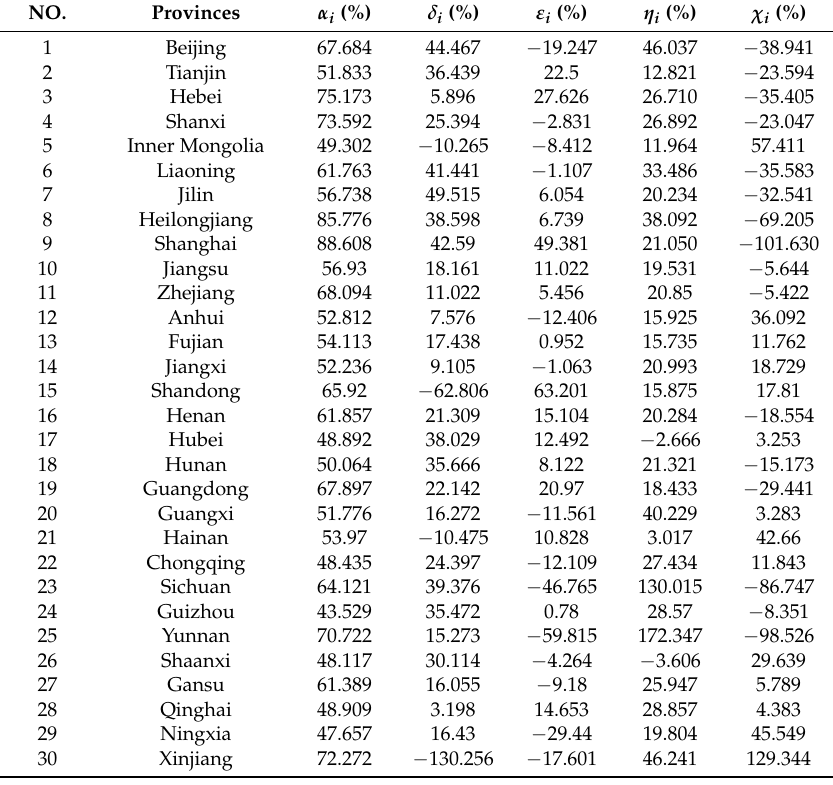
Table A5. Second-stage relative decomposition results for each